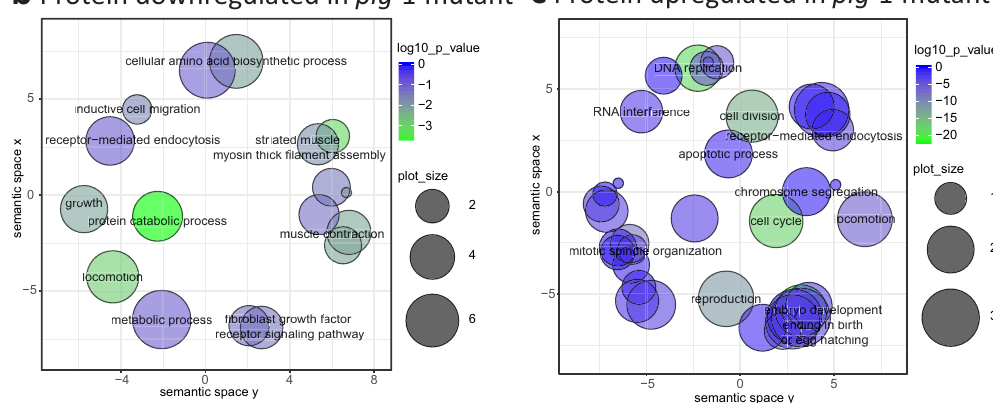
Figure 4. Global protein abundance changes in pig - 1 mutant embryos. ( a ) Volcano plot (in log 10 vs. log 2 scale) depicting protein abundance changes in the pig - 1 mutant embryo compared to wild-type embryos. The dashed orange and red lines indicate a p-value of 0.05 and 0.01 (1.3 and 2 in log 10 scale), respectively. Boxed proteins were at least 2-fold down- or upregulated with a p-value of 0.05 and used for gene ontology term analysis. An interactive version of this volcano plot is available online via the EPD. To illustrate its functions, several proteins are highlighted and for one of them a tooltip with further available information is displayed. ( b and c ) Gene ontology term (GO) enrichment (biological process) of pig - 1 -variant proteins (boxed in the volcano plot). x and y-axis indicate semantic space used to group GO terms of related biological processes. Bubble sizes indicate the frequency of the GO term in the underlying C . elegans protein database (larger bubbles reflect more common terms) and bubble colour indicates statistical significance (the greener, the lower the p-value). ( b ) GO term analysis of proteins with at least 2-fold downregulated abundance in the pig - 1 mutant (Supplementary Table 5a). ( c ) GO term analysis of proteins with at least 2-fold upregulated abundance in the pig - 1 mutant (Supplementary Table